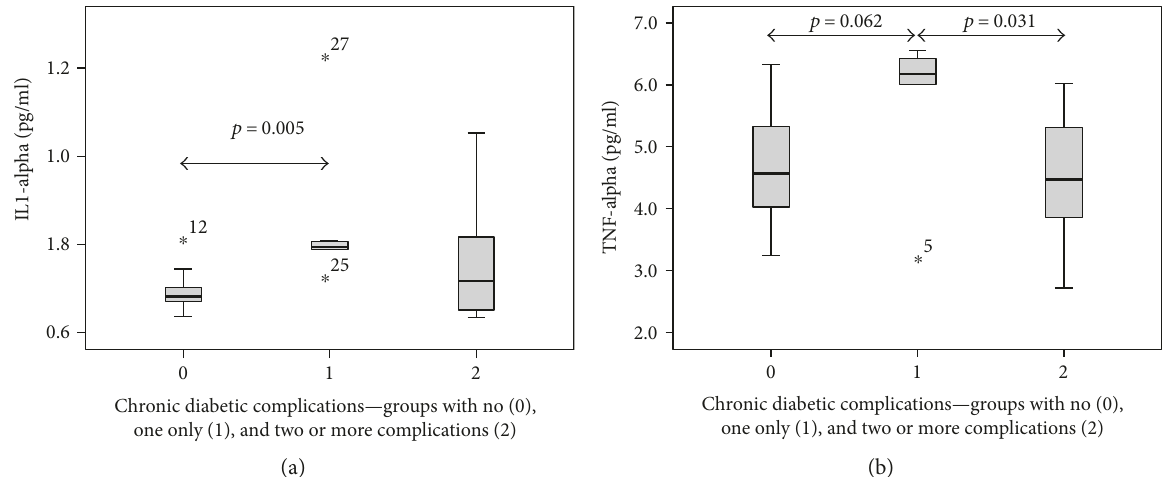
Figure 2: In fl ammatory cytokines and chronic diabetic complications. The highest production of IL-1alpha was observed in patients with one chronic diabetic complication which signi fi cantly di ff ered from patients without any diabetic complications. TNF-alpha expression levels were similar to those seen for IL-1alpha, but in addition, patients with multiple complications had signi fi cantly lower levels of TNF-alpha than those with only one complication. (a) IL-1alpha. (b) TNF-alpha — the highest TNF-alpha production was also observed in patients with one chronic diabetic complication.